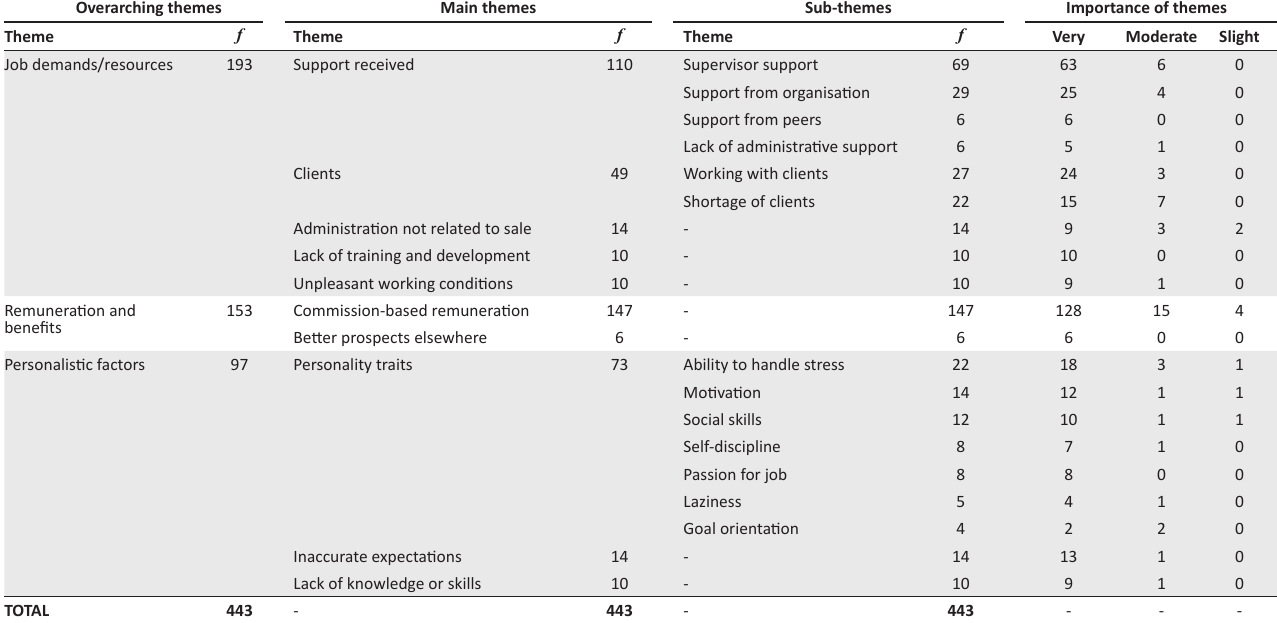
TABLE 1: Factors that the personal financial advisors regarded as predictive of the intention to quit among their peers. Overarching